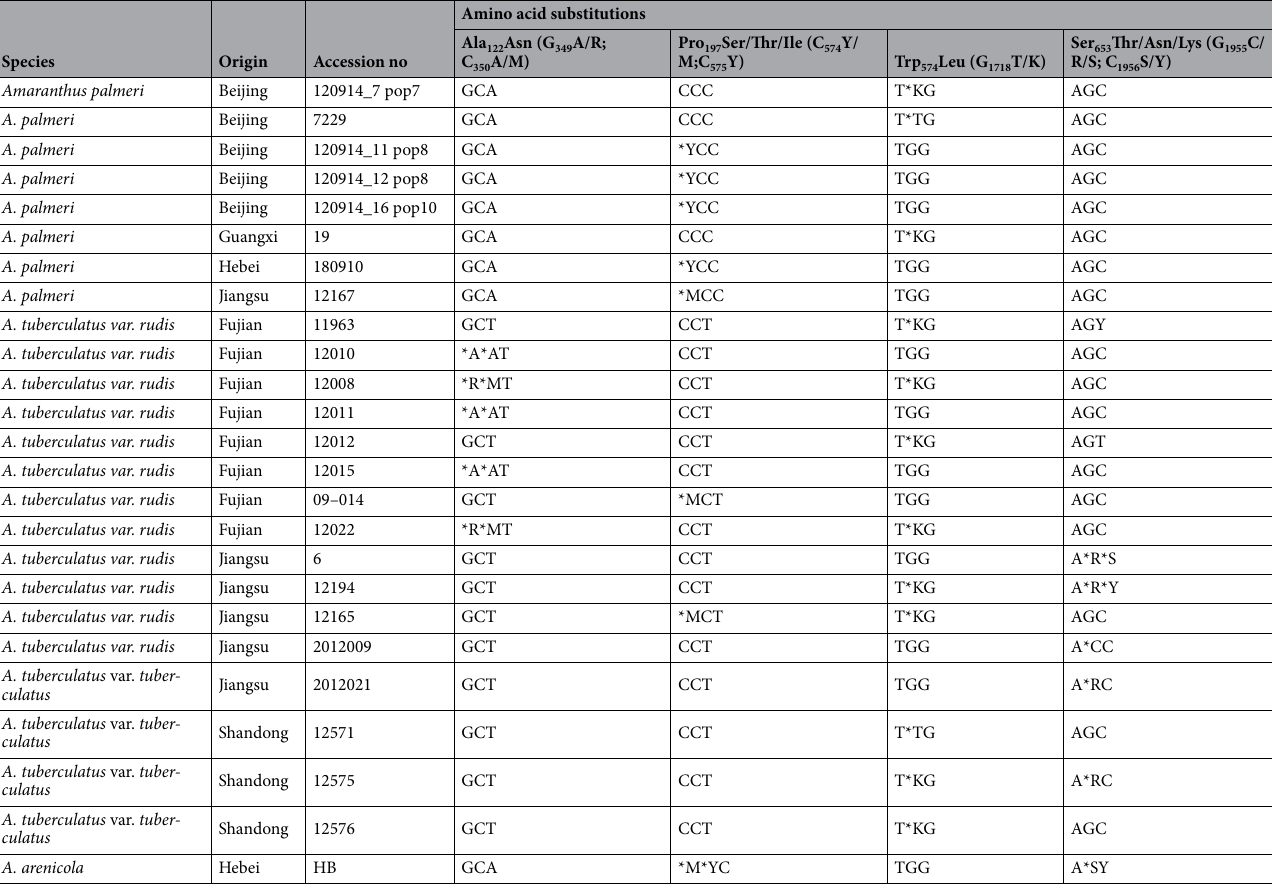
Table 2. Amino acid substituts in sampled species with R ALS alleles *